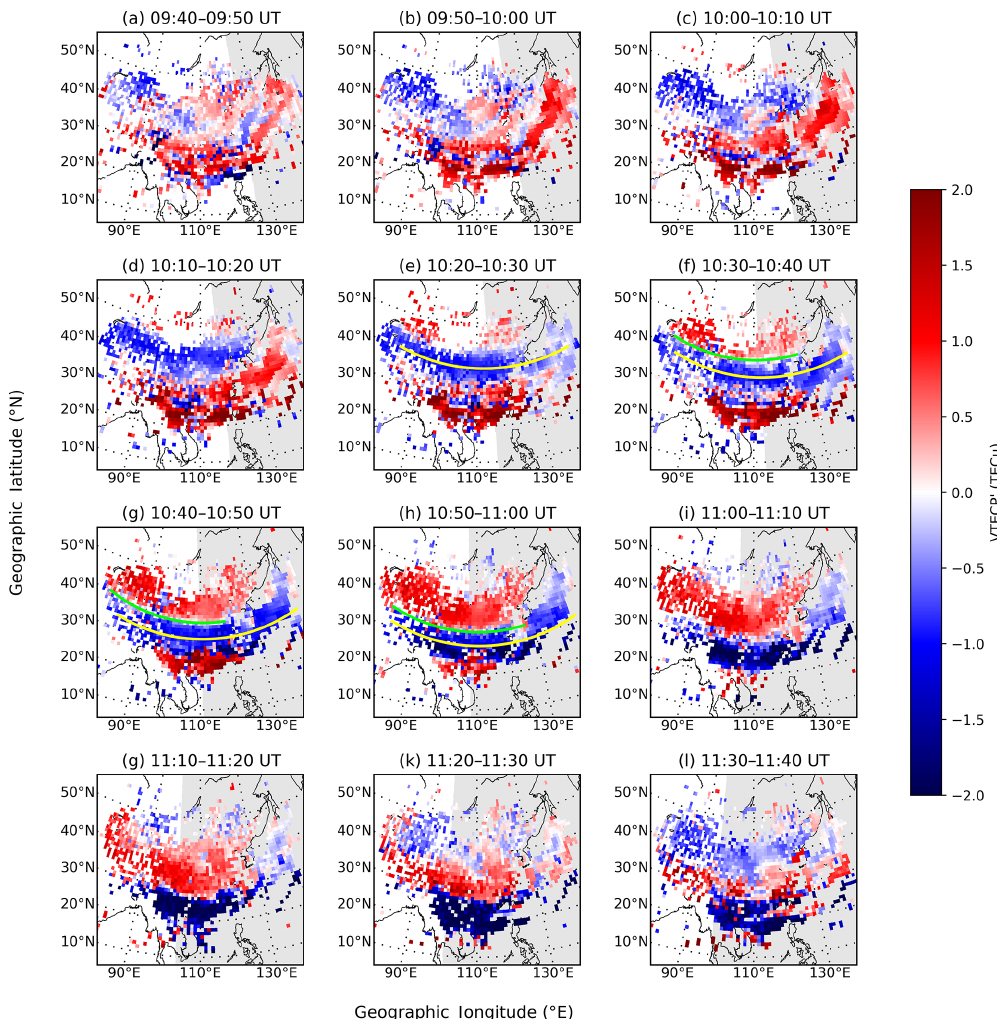
Figure 4. A series of 2-D VTECP (cid:48) maps over the eastern Asian sector from the period of 09:40–09:50 to 11:30–11:40UT on 17 March 2015. The gray areas represent the nightside. The color bar represents the VTECP (cid:48) (units: TECu), which is transformed from the original VTECP value with Eq. (3) for a more viewer-friendly color map. The green and yellow lines illustrate the least-square fittings (order two) for